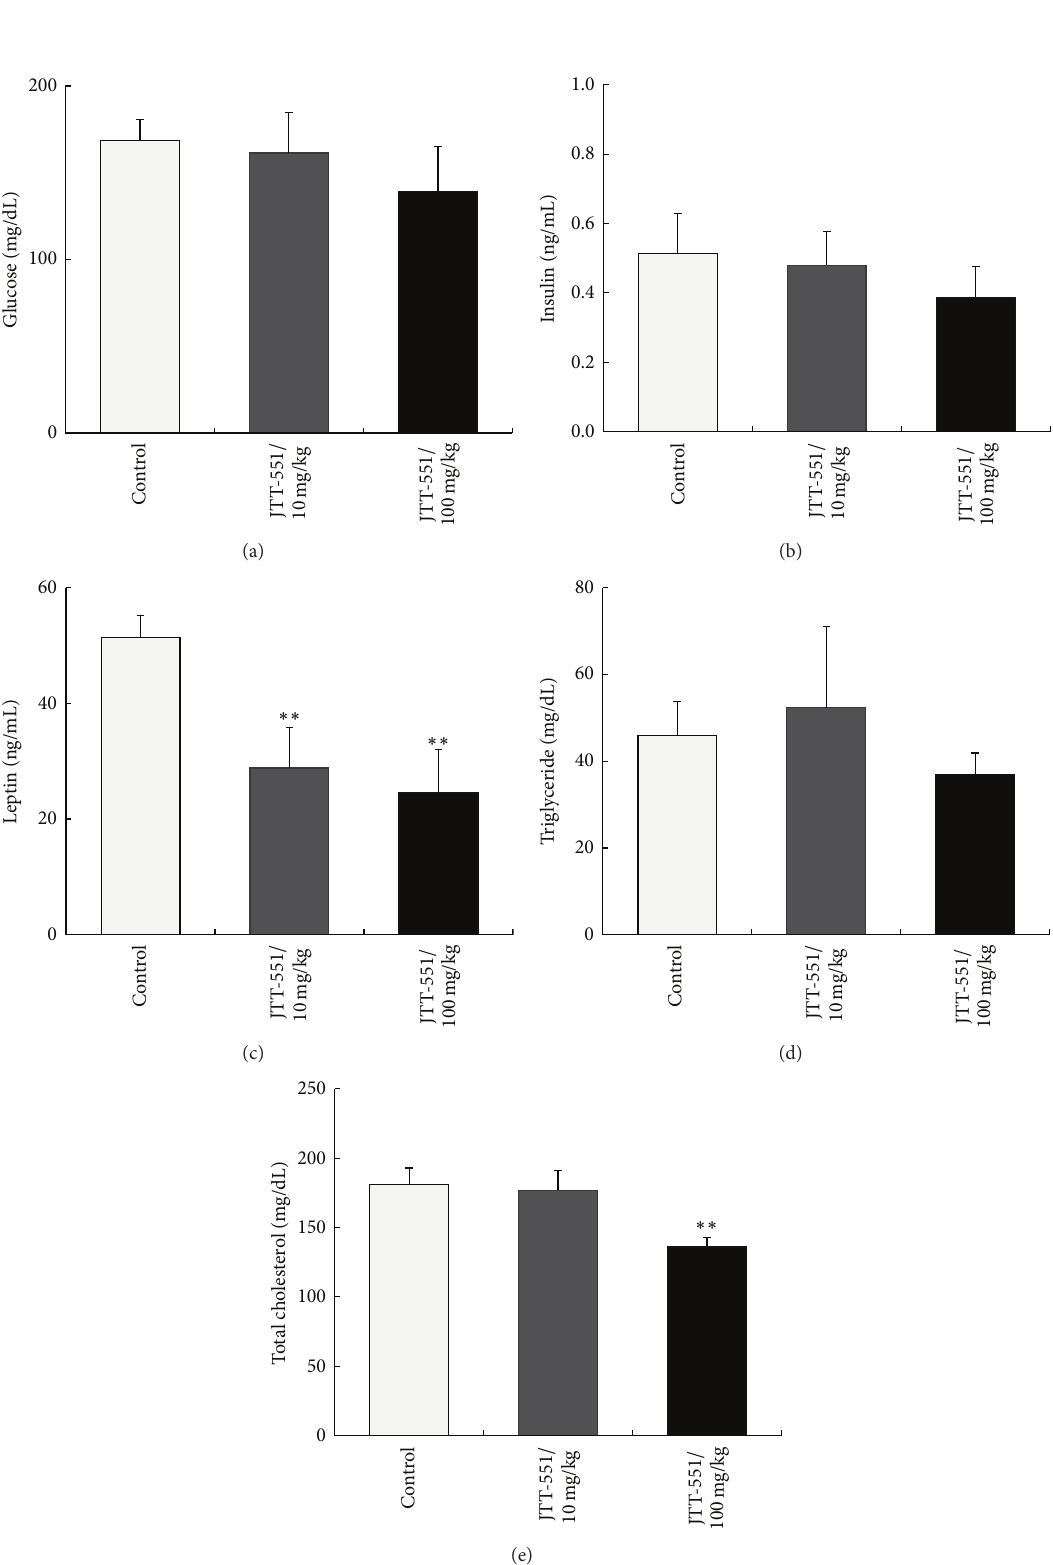
Figure 5: Effects of JTT-551 on blood glucose (a), insulin (b), leptin (c), triglyceride (d), and total cholesterol levels (e) in fasting DIO mice. DIO mice were given 10 or 100 mg/kg food containing JTT-551 for six weeks. Data represent mean ± SD ( 𝑛 = 6 ). ∗∗ 𝑃 < 0.01 : significantly different from the control by Dunnett’s test